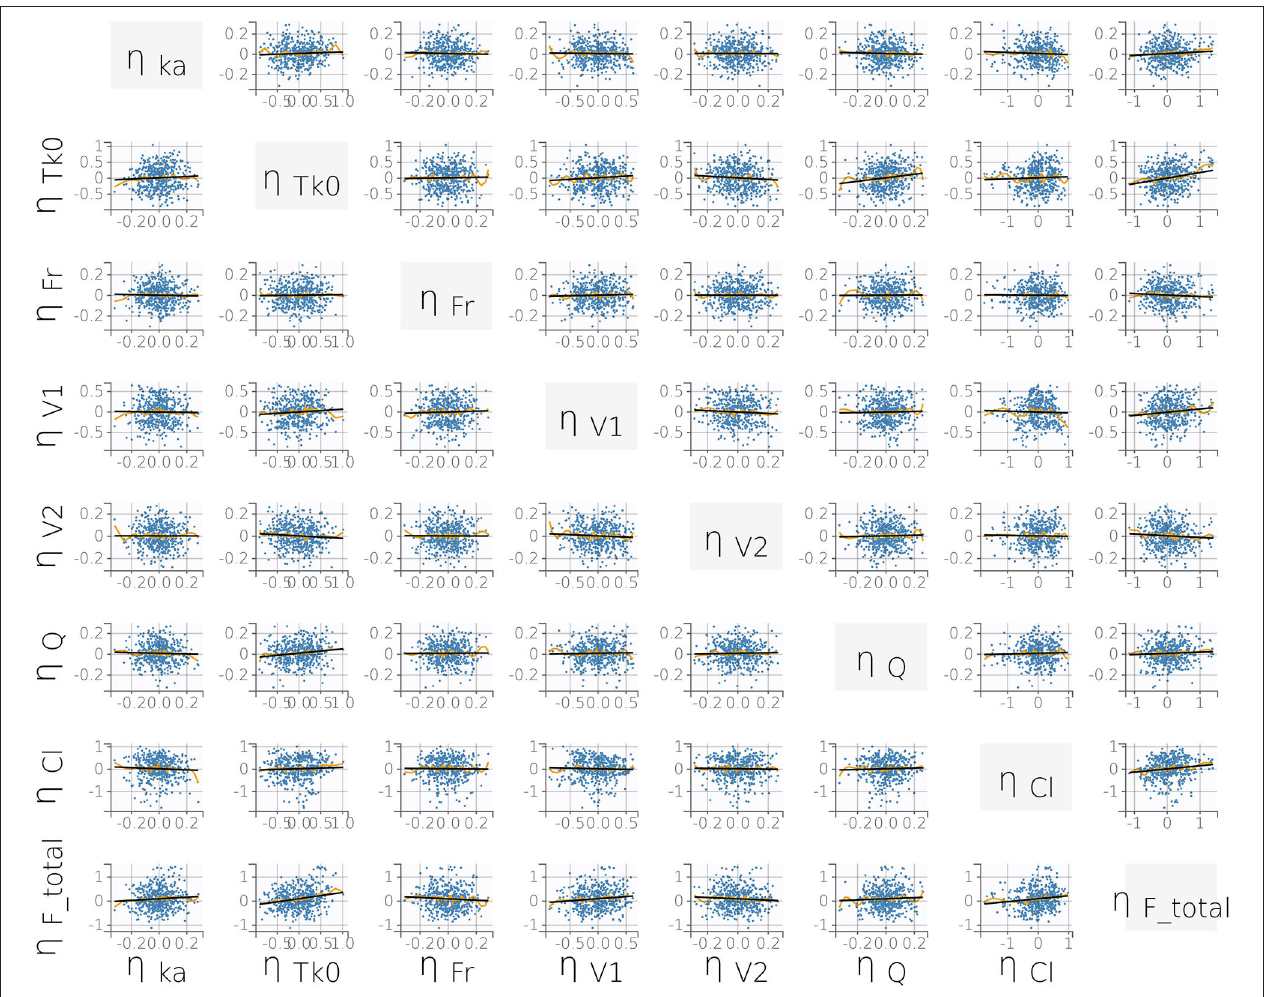
FIGURE 4 | Correlation plot matrix of the random effects (i.e., the η i ). All correlation coefficients were estimated to be low ( r ≤ 0.15) and did not meet the threshold for inclusion (Pearson’s correlation test, P < 0.05). This supports our final statistical model choice. Yellow lines are splines of correlation while black lines are simple linear